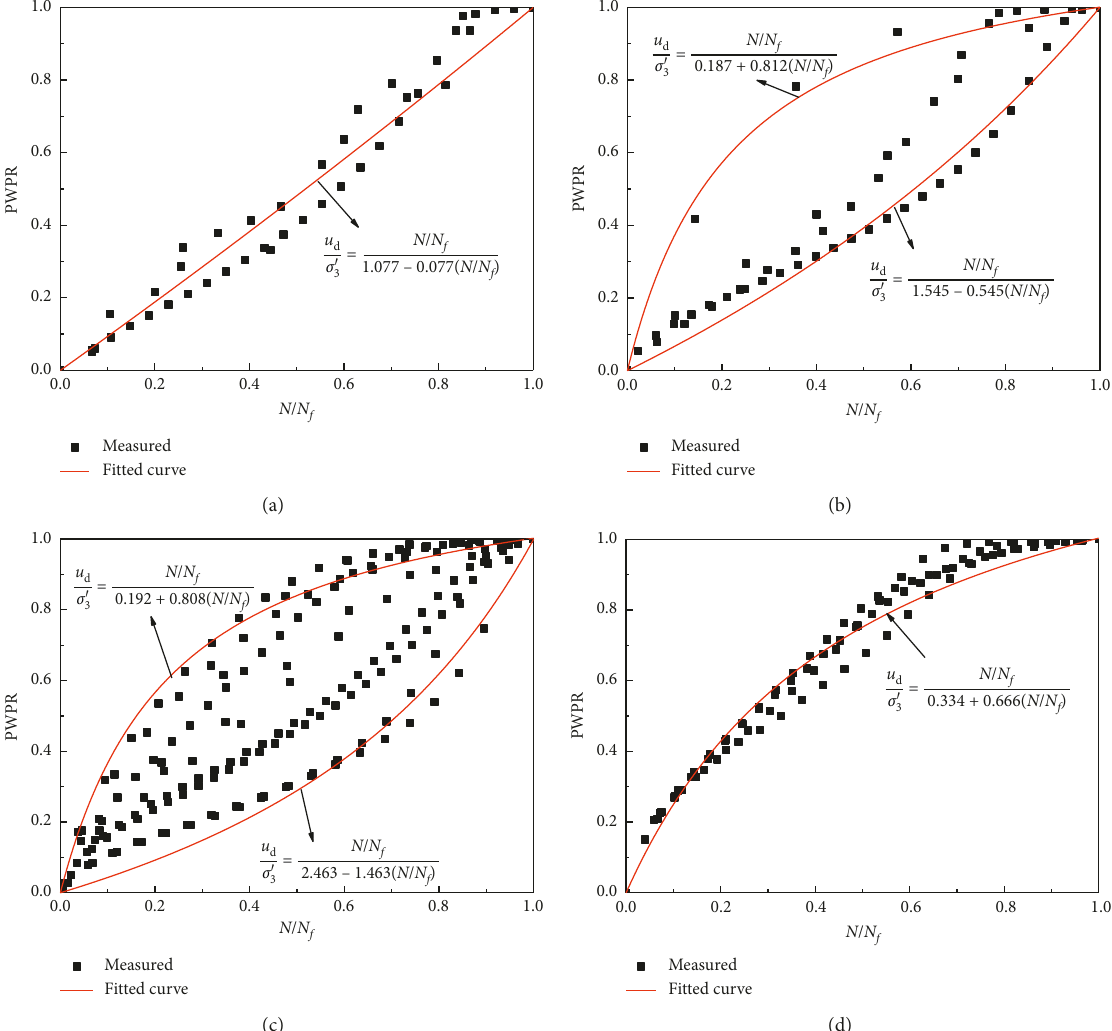
Figure 14: Pore water pressure ratio (PWPR) for different rubber content cases for (a) RC � 0%, (b) RC � 3%, (c) RC � 5%, and (d) RC �